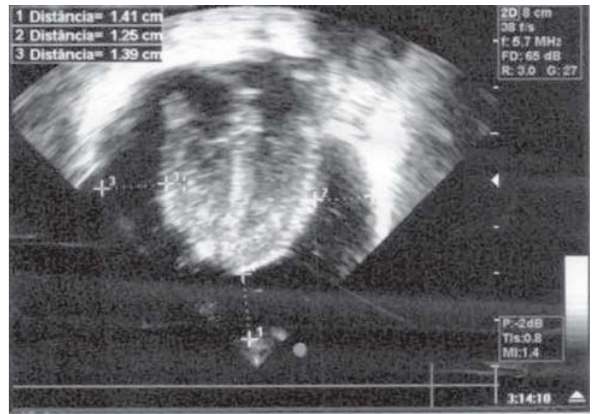
Fig. 1 - Ecocardiograma do caso 1 mostrando derrame pericárdico